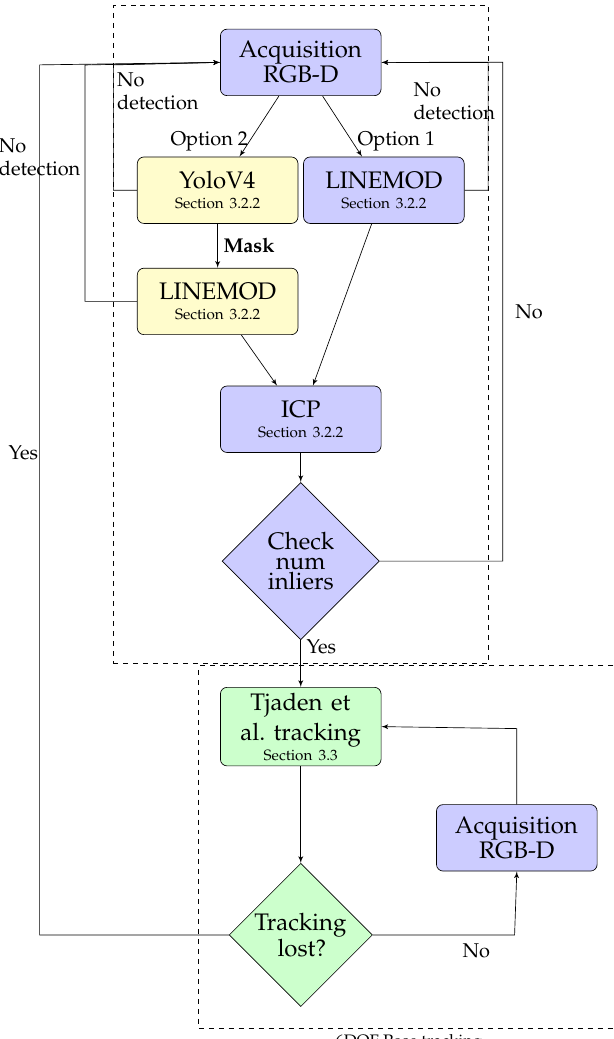
Figure 3. Flowchart of AR tracking